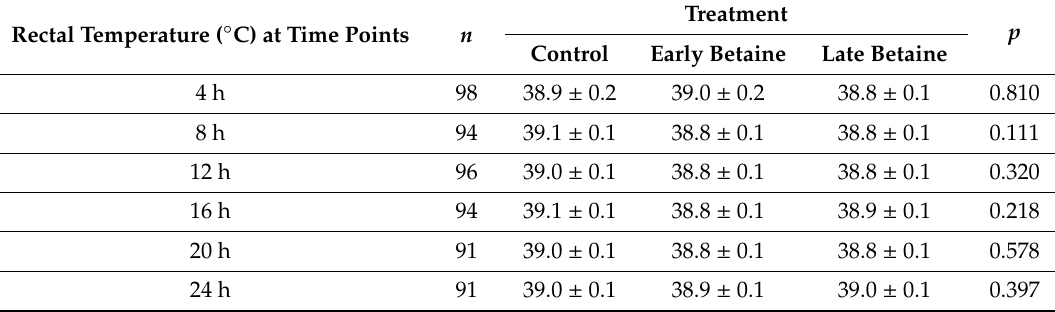
Table 6. Lamb rectal temperatures from 4 to 24 h post-partum (Estimated marginal means ± SEM). Rectal Temperature ( ◦ C) at Time Points n